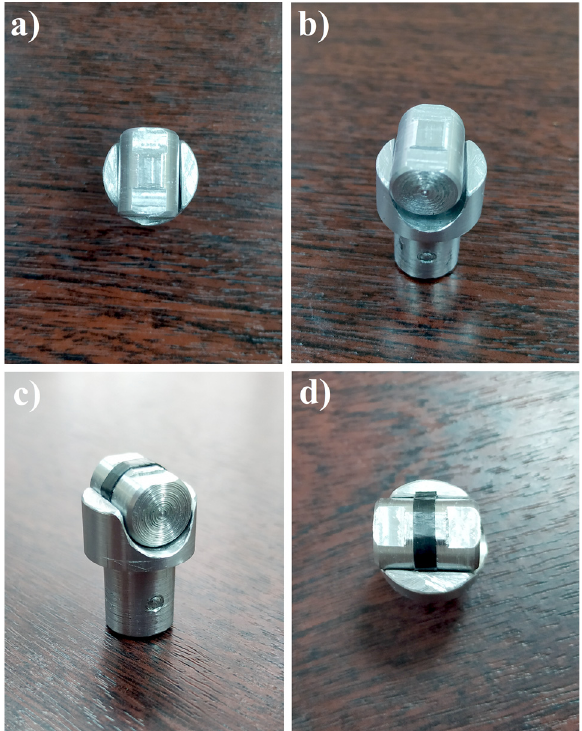
Figure 3. Pin form in tribological tests: ( a , b ) pin form without sample, ( c , d ) pin form with UHMWPE films samples.